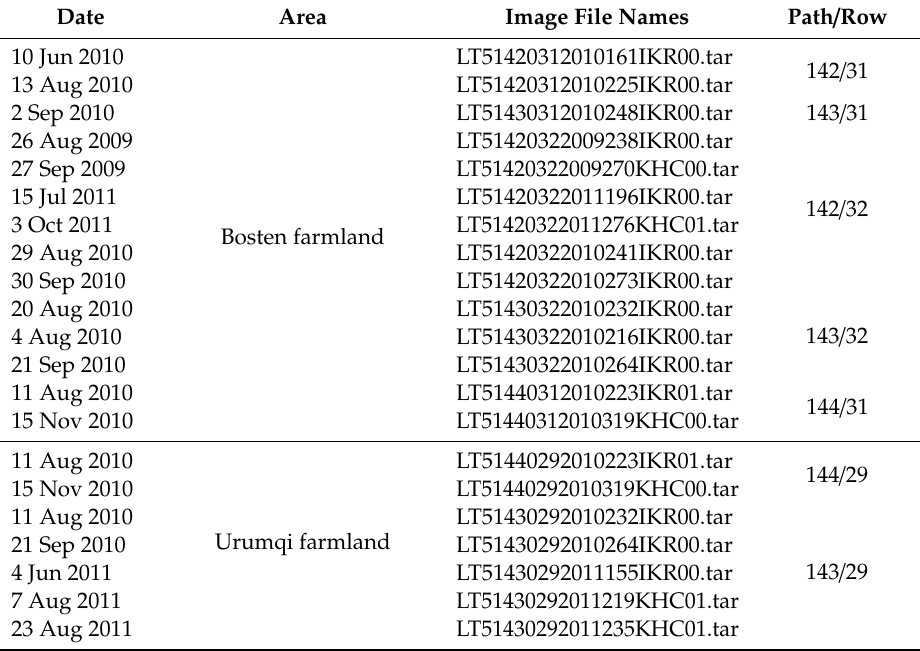
Table 2. Data list of Landsat 5 top of atmosphere (TOA) products used in this